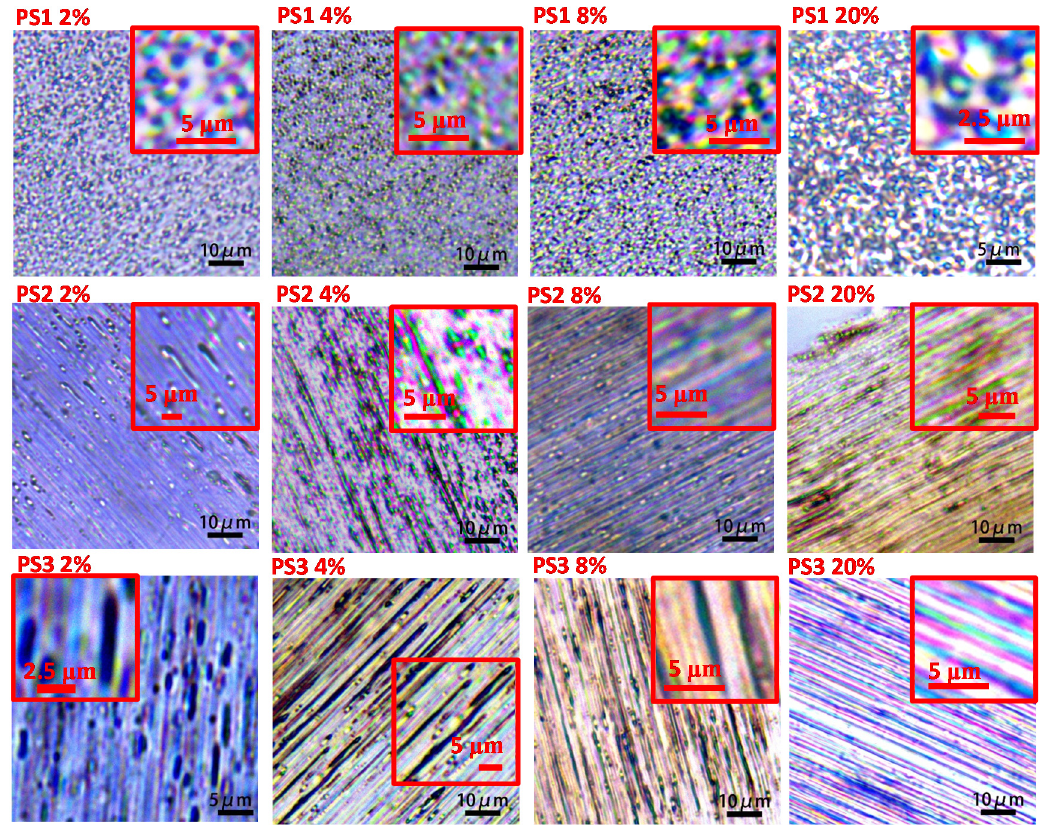
Figure 10. The optical micrographs of PS/PP blend fibers.